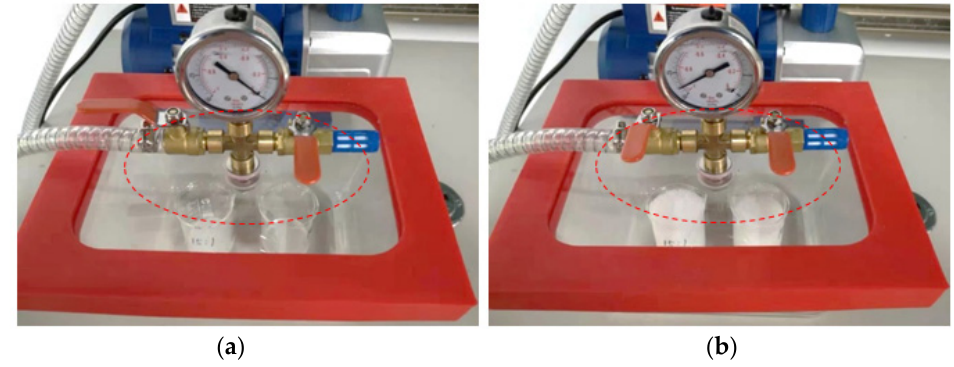
Figure 5. ( a ) Status of PDMS before pressurization; ( b ) status of after pressurization. (4)